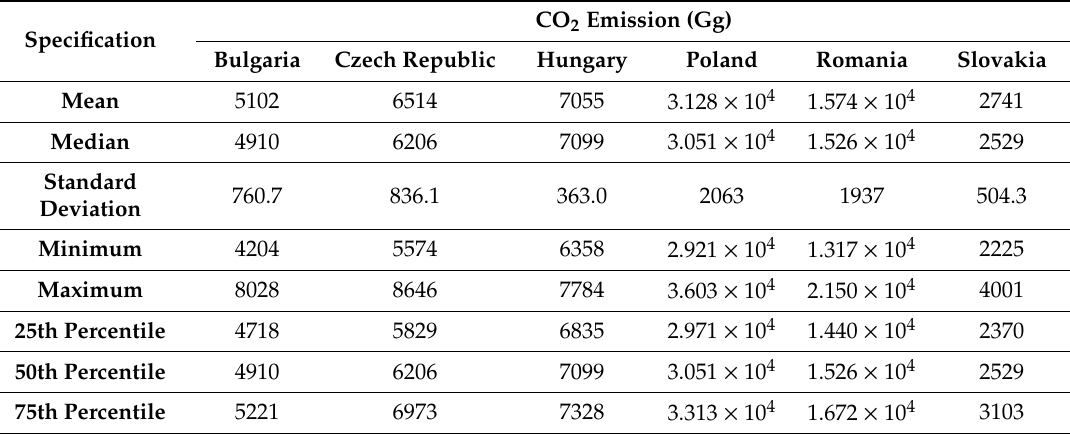
Table 1. CO 2 emission in the countries of Central and Eastern Europe in 1992–2016.